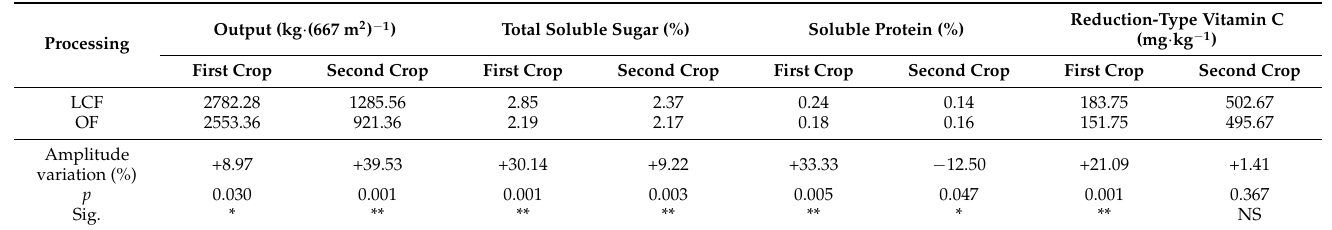
Table 7. Effect of light conversion films (LCF) and ordinary film (OF) on crop yield and quality with different